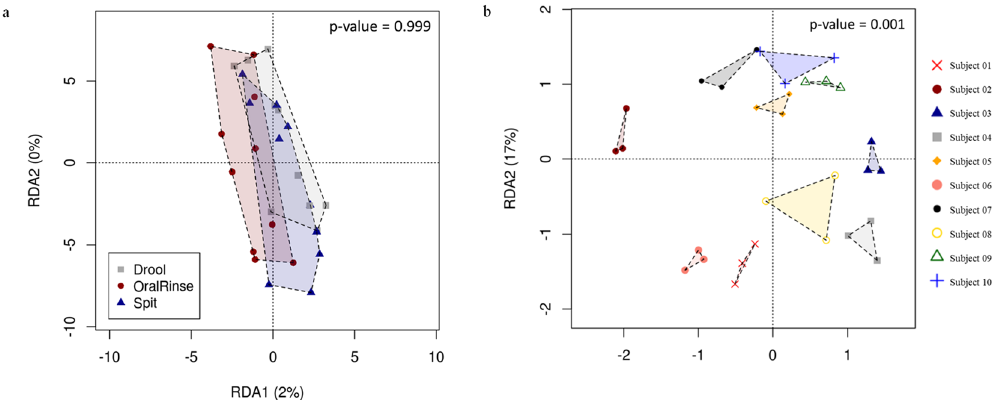
Figure 7. Salivary microbiome genera redundancy analysis on different ( a ) saliva fractions and ( b )